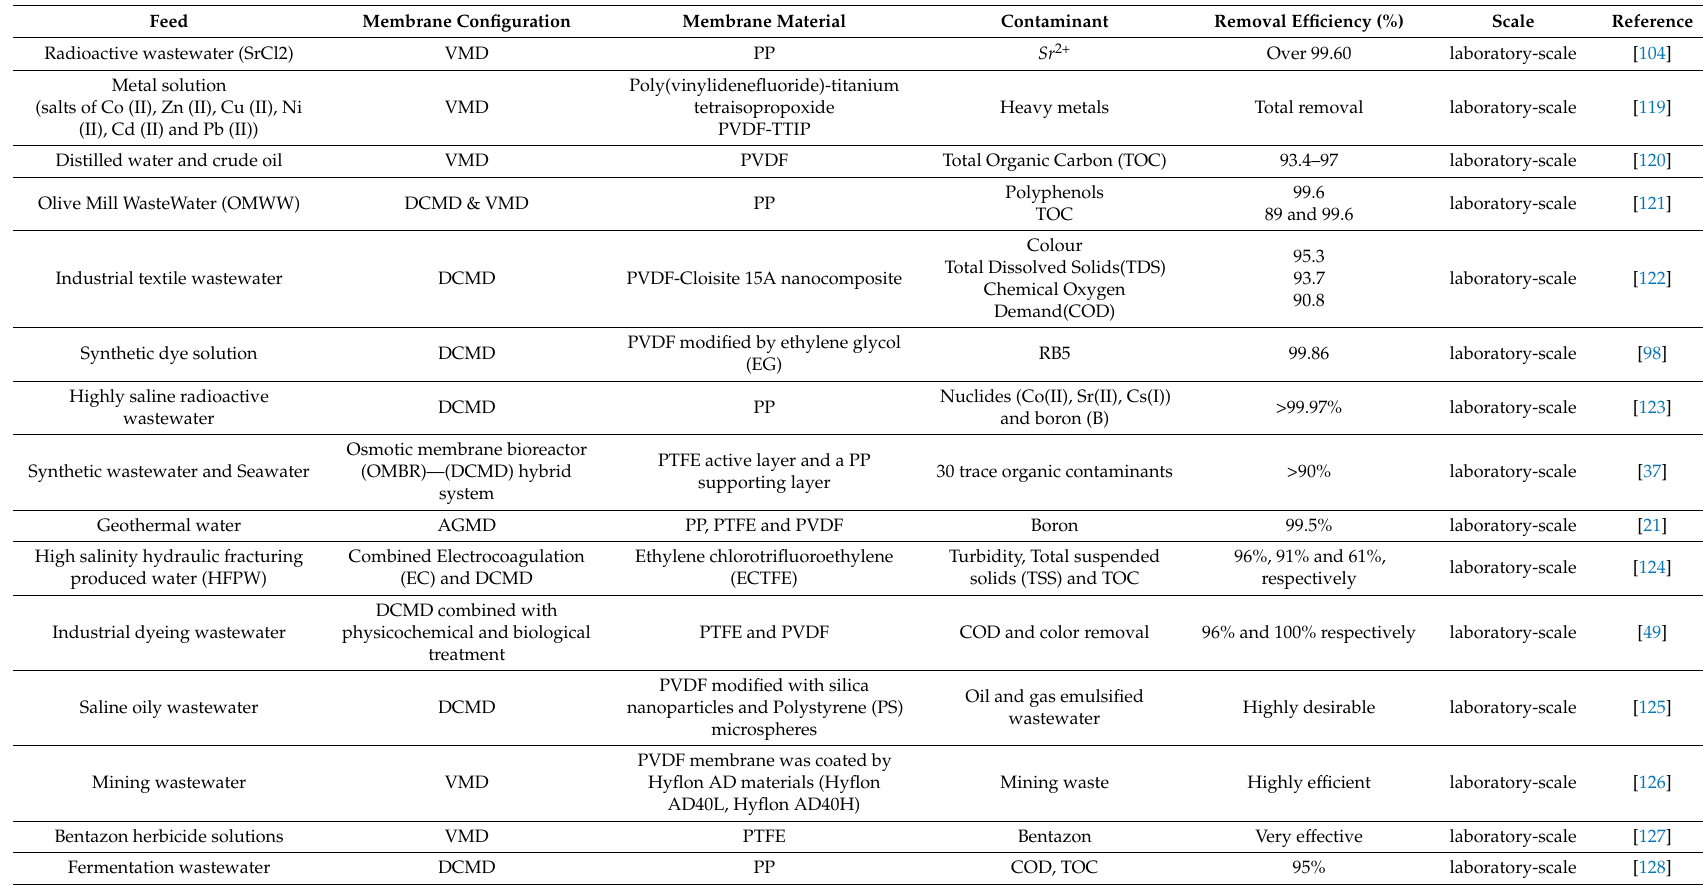
Table 6. Summary of MD applications in wastewater